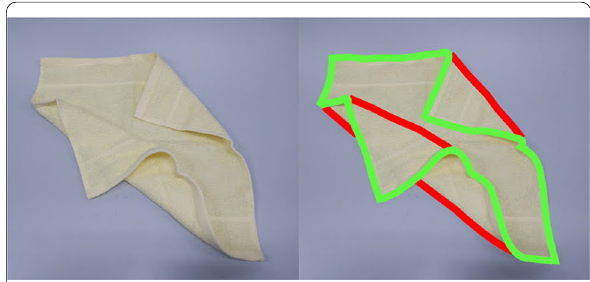
Fig. 1 Example of physical edges (green) and nonphysical edges